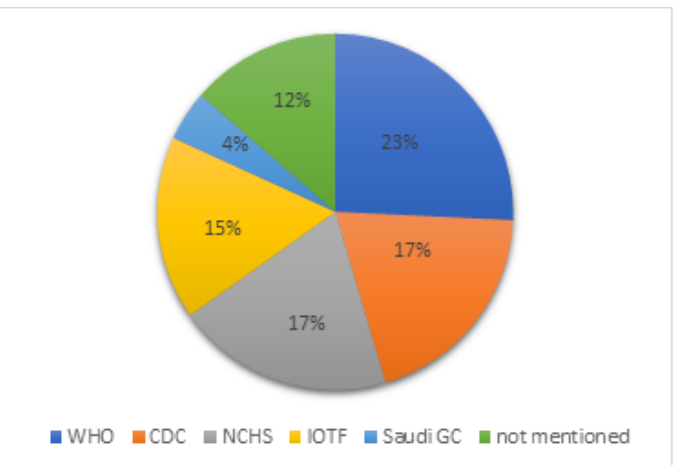
Figure 2. The use of growth standards in Saudi children and adolescents between 1980 and